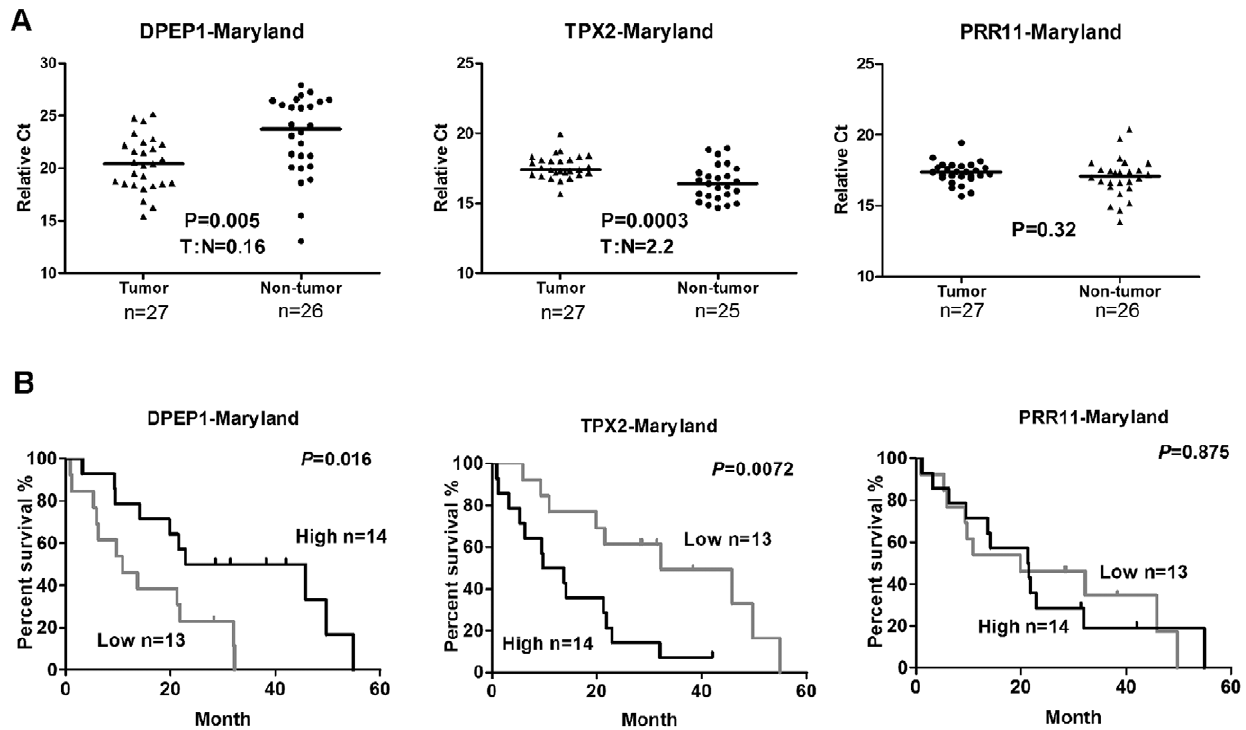
Figure 2. Validation of DPEP1 and TPX2 in independent Maryland cohort. A: DPEP1 and TPX2 were differentially expressed in Maryland validation cohort at a similar level as in Germany cohort. Dot plots represent gene expression level with relative threshold cycle value (Ct) normalized with endogenous control gene GAPDH. Bars indicate median value. Wilcoxon matched-pairs t-tests P value and tumor: non-tumor ratios (T:N) are indicated in the graphs. B: The association of DPEP1 or TPX2 with patient survival was validated in the Maryland cohort. PRR11 was not associated with survival in the validation cohort.